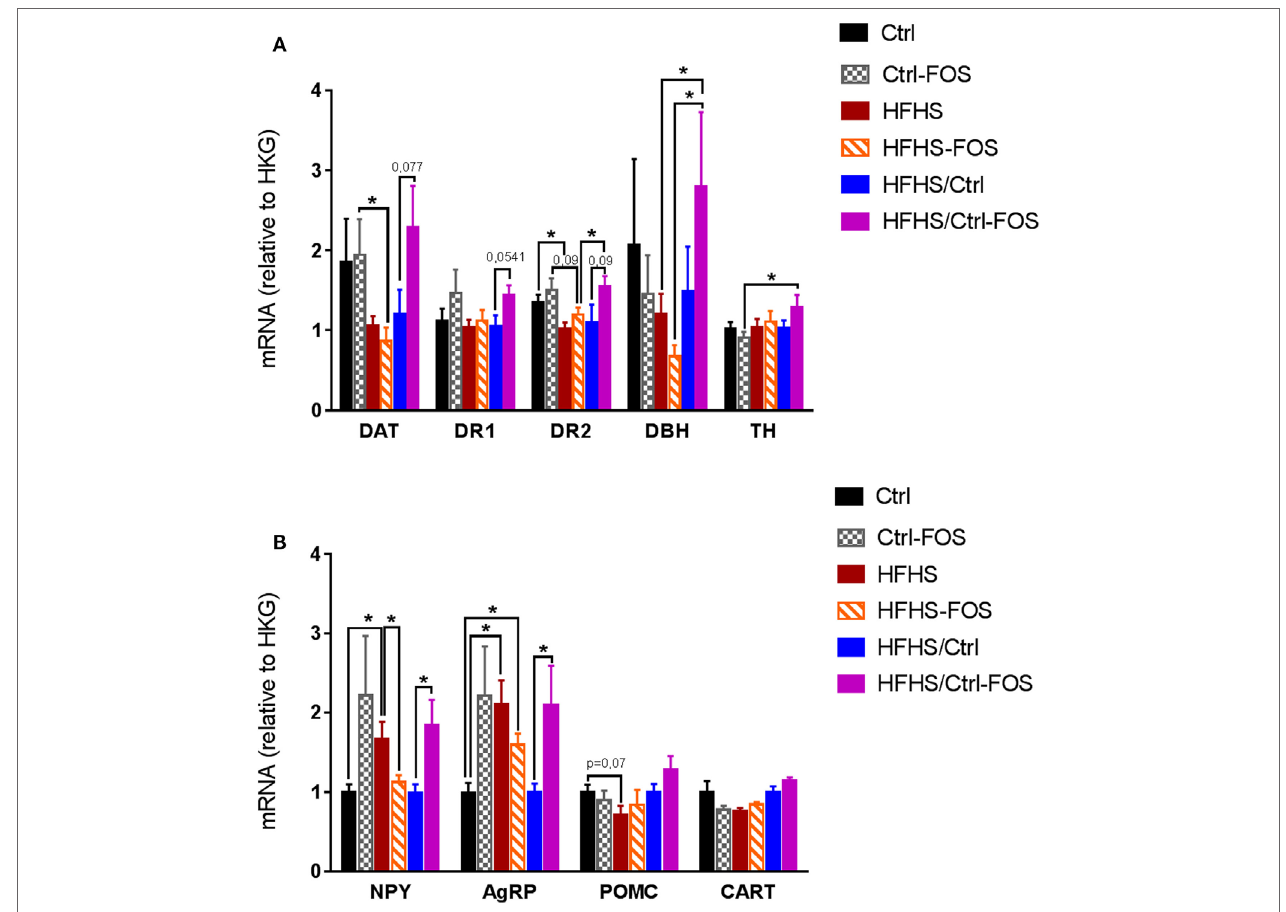
FigUre 4 | Real-time PCR analysis of mRNA content (a) in the nucleus accumbens, for gene encoding for dopamine transporter (DAT), dopamine receptor 1 (DR1), dopamine receptor 2 (DR2), dopamine beta hydroxylase (DBH), and tyrosine hydroxylase (TH) and (B) in the hypothalamus for neuropeptide Y (NPY), Agouti-related protein (AgRP), Pro-opiomelanocortin (POMC), and cocaine and amphetamine-regulated transcript (CART) in Ctrl (black), Ctrl-fructo-oligosaccharides (FOS) (gray), HFHS (red), HFHS-FOS (orange), HFHS/Ctrl (blue), and HFHS/Ctrl-FOS (purple). Expression level corresponds to a ratio relative to housekeeping gene (HKG). Data are expressed as mean ± SEM of eight mice in each group. Significant differences from a two-way ANOVA, Bonferroni Post hoc test (* P < 0.005) (a,B)